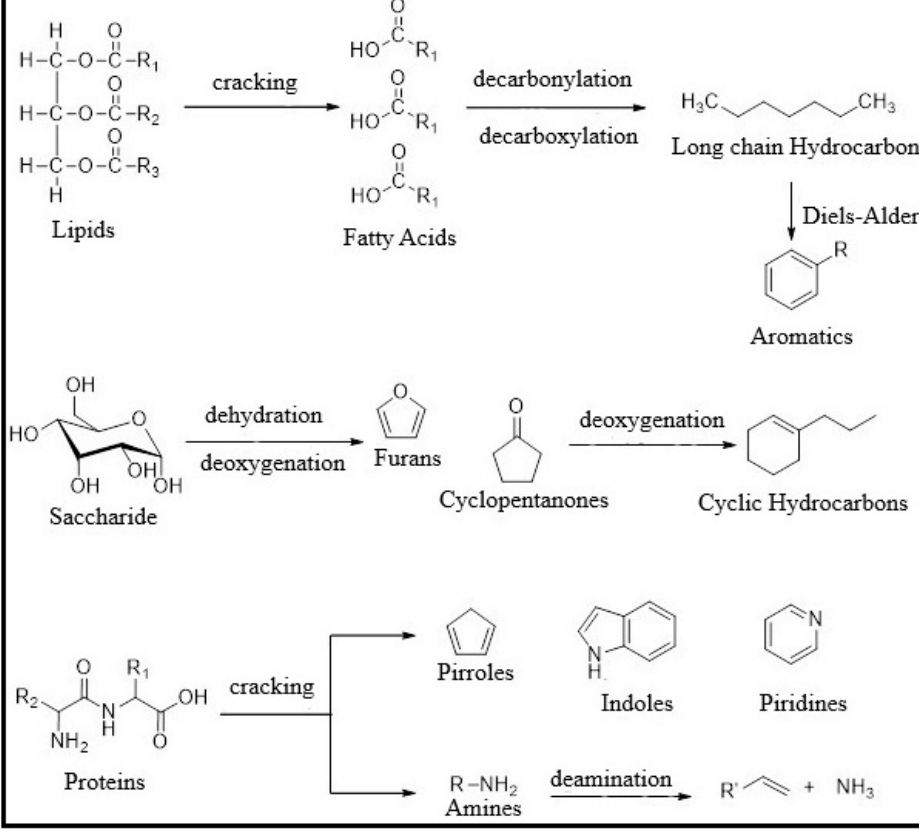
Figure 7. Infrared spectra of the bio-oil obtained by solar pyrolysis of Spirulina platensis. Table 6. Main compounds found in the bio-oil obtained by solar pyrolysis. Hydrocarbon